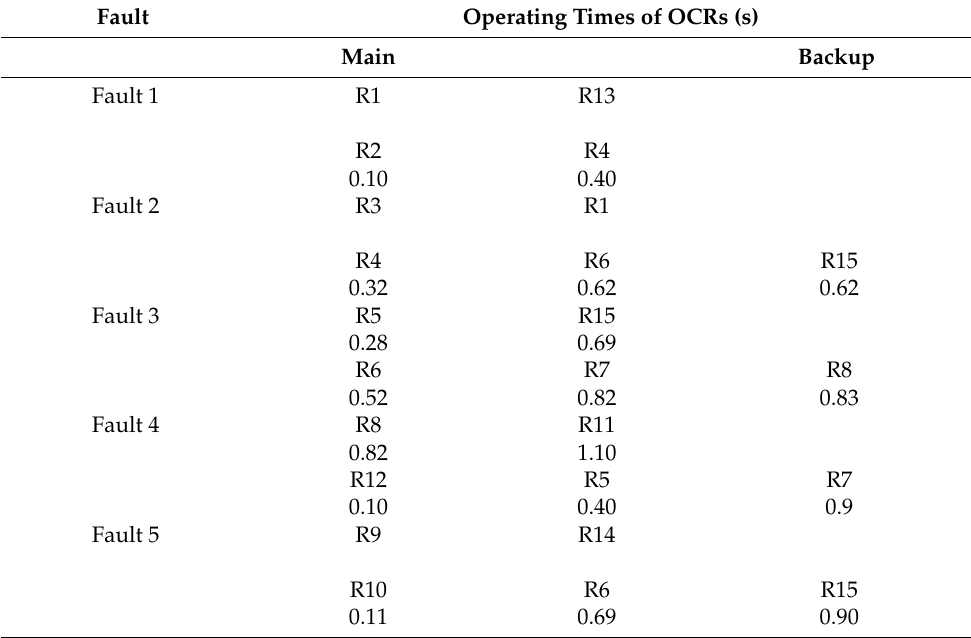
Table 8. Operating times for Scenario